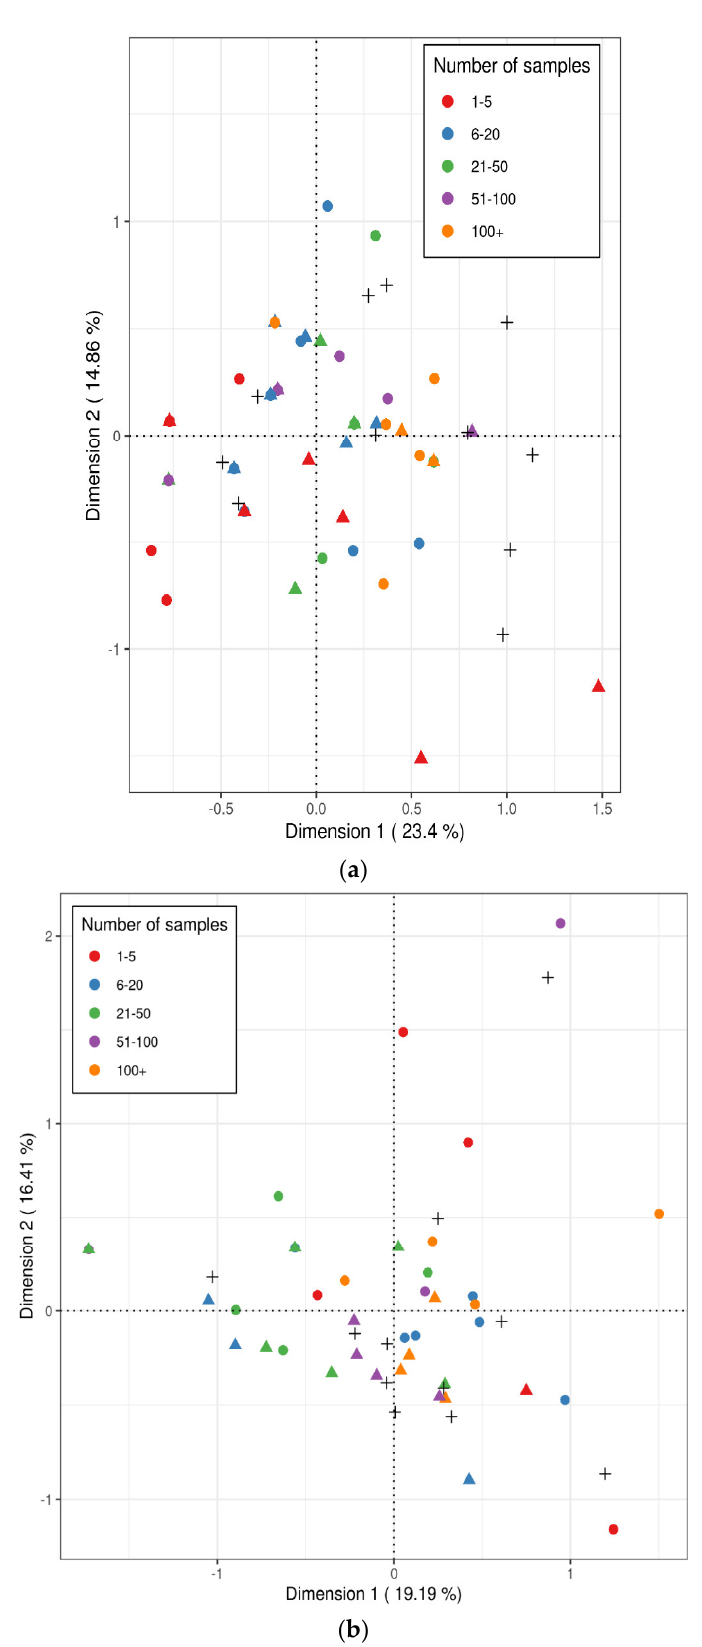
Figure 11. ( a ): Correspondence analysis plot of crops and sites categorised by NoS (triangles denote Pannonian sites; circles denote Continental sites). ( b ): Correspondence analysis plot of wild taxa and sites categorised by NoS (triangles denote Pannonian sites; circles denote Continental sites). Crosses correspond to the